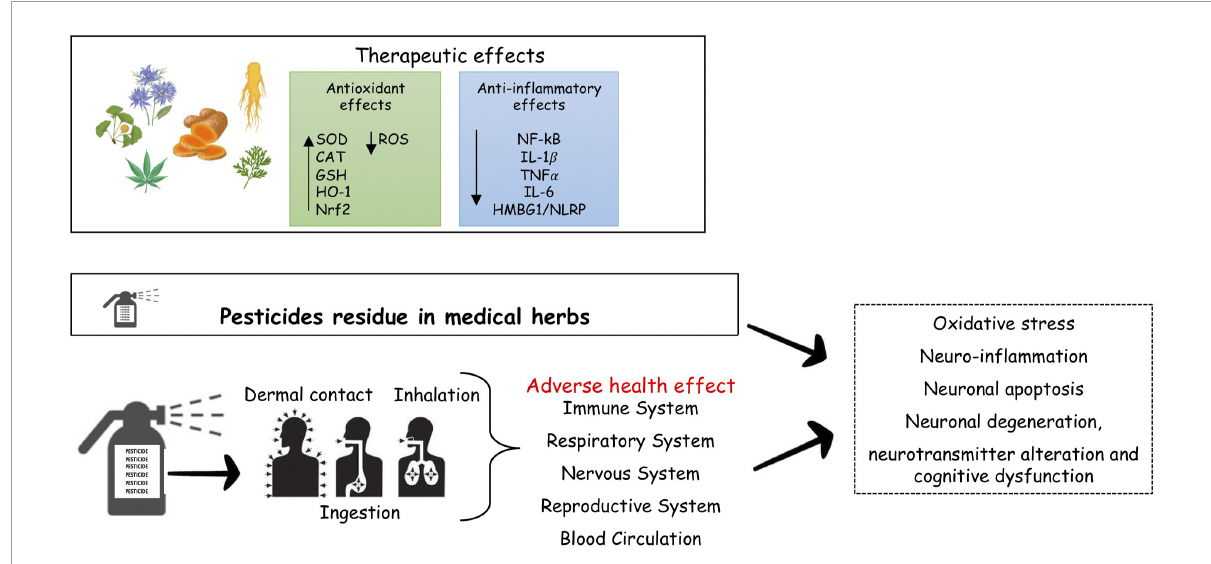
FIGURE1 Pesticides and risk of neurodegenerative diseases. Many medical herbal have therapeutic effects in MS, reducing inflammation and oxidative stress, the major driver of MS. Pesticides both occupational pesticides exposure through agricultural activities, and consumers exposure to residual pesticide present in food and herbal medicines, may represent a risk for brain damage, cognitive deficits, behavioral and neurodegeneraive disorders as results of dysregulation of molecular target. SOD, superoxide dismutase; CAT, catalase; GSH, glutathione; HO-1, heme oxygenate-1; Nrf2, nuclear factor E2-related factor-2; NF-kB, nuclear factor k-light-chain-enhancer of activated B cells; IL, interleukin; TNF, tumor necrosis factor; HMBG1/NLRP, high mobility group box1/nucleotide-binding oligomerization domain, leucine rich repeat and pyrin domain